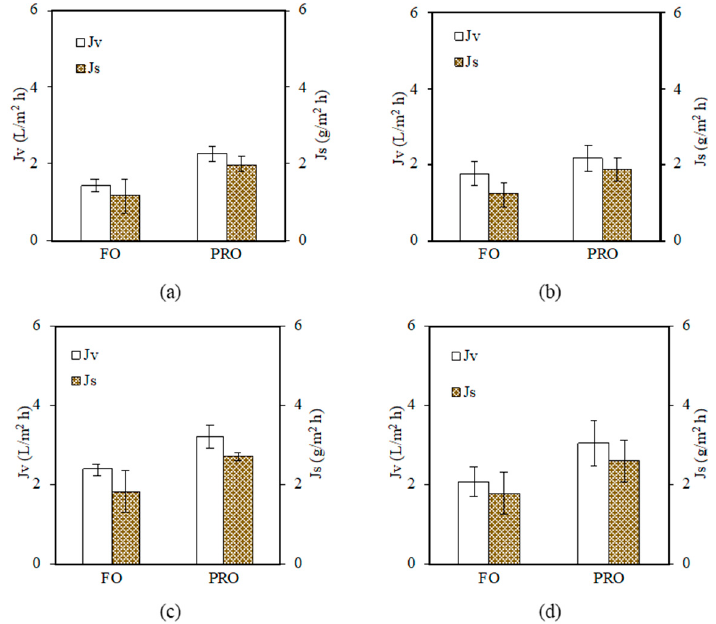
Figure 10. Water flux ( J v ) and reverse solute flux ( J s ) of TFC NF membrane under FO and PRO mode: ( a ) TFC NF (control), ( b ) PDA/GO0.3, ( c ) PDA/GO0.5, and ( d ) PDA/GO0.7 (Operation mode: engineered osmosis; feed solution: AT-POME; draw solution: 4 M MgCl 2 ; cross flow velocity: 0.3272 m/s for both feed and draw solution; operation period: 2 h; temperature: 24 °C (+1)).